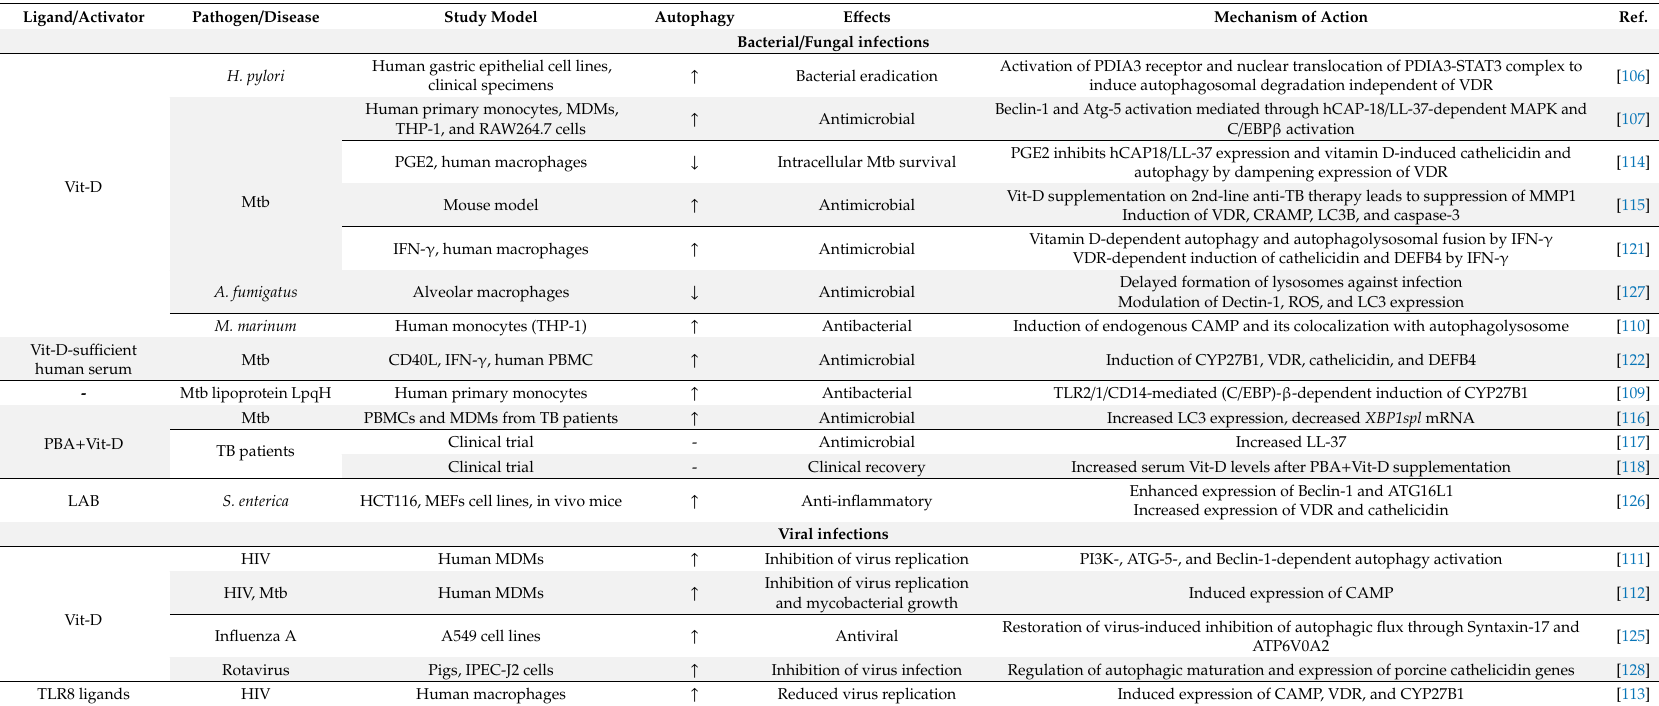
Table 1. Vitamin D receptor (VDR) in autophagy-mediated host defense against